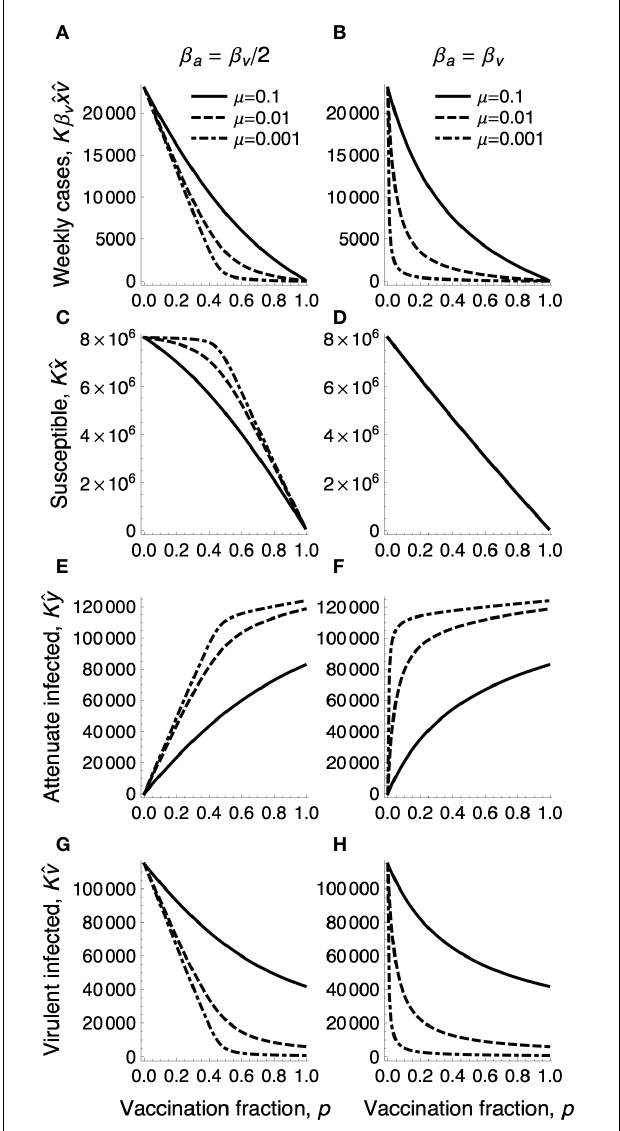
FIGURE 2 |The densities in endemic equilibrium under the immunization fraction p . The number, K β v ˆ x ˆ v of hosts newly infected by virulent virus in a week (top row), the equilibrium number K ˆ x of susceptible hosts (second row), that K ˆ y of attenuated virus infected hosts (third row), and that K ˆ v of virulent virus infected hosts (bottom row) are plotted as a function of immunization fraction p for varying mutation rates μ for the emergence of virulent virus from an attenuated virus (sold: μ = 0.1, dashed: μ = 0.01, dot dashed: μ = 0.001).The population size K is 100 million, β = 2.5 is the transmission rate of virulent virus. (A,C,E,G) The transmission v rate of attenuated virus is half of that of virulent virus: β a = 1.25. (B,D,F,H) β a is the same as β v . Other parameters are γ a = γ v = 0.25, u = 0.00025.